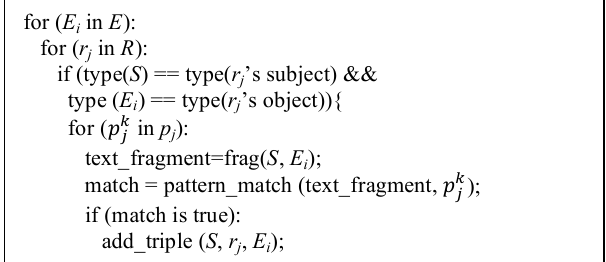
Table 3 Extraction